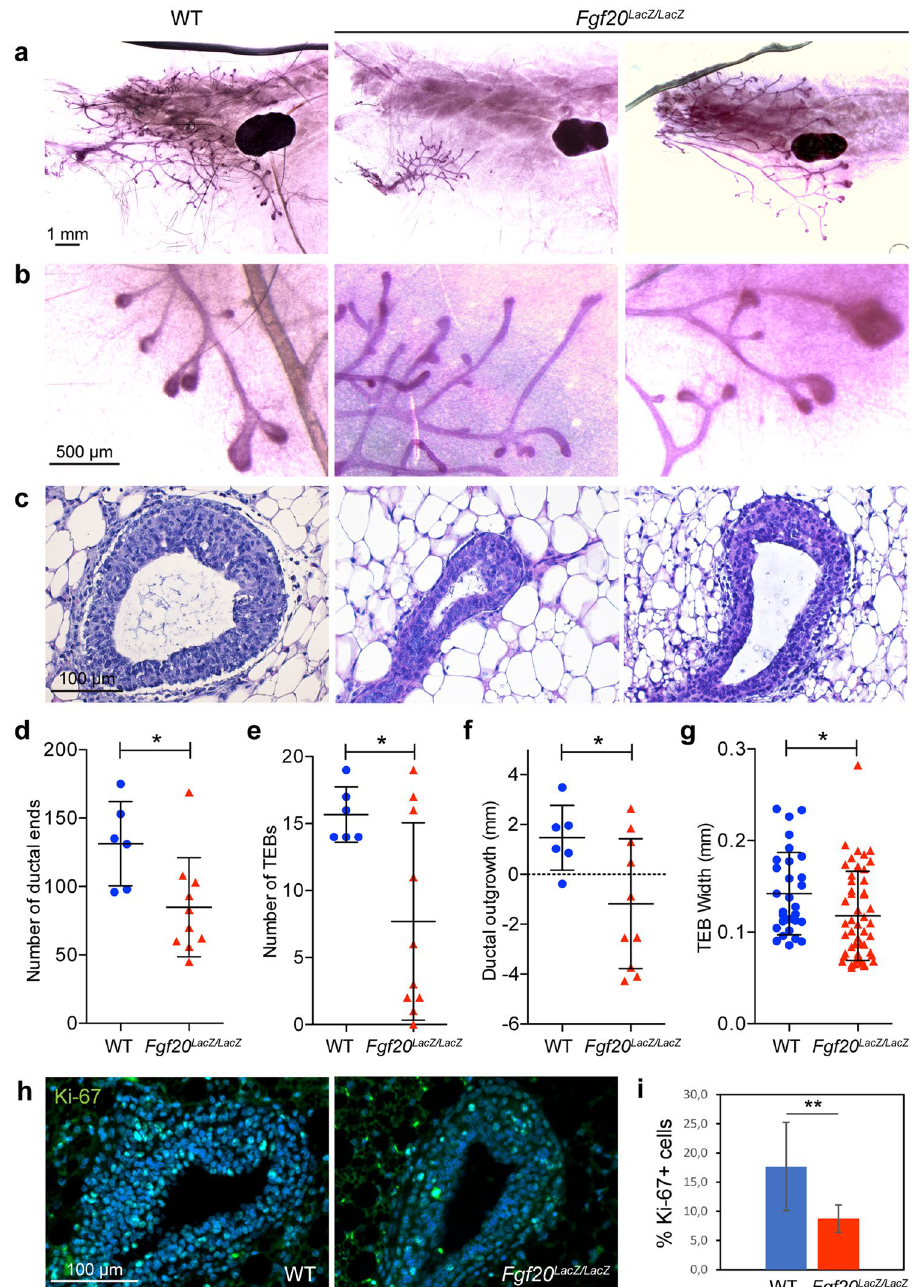
Figure 5. Fgf20 deficiency compromises TEB formation and ductal invasion. ( a–c ) Carmine alum stained ductal trees of the 4 th mammary gland ( a , b ) and histology of TEBs ( c ) of WT and Fgf20 LacZ/LacZ mice at 5 weeks of age. ( d–g ) Quantification of the ductal ends ( d ), TEBs ( e ), ductal outgrowth (measured as the distance of furthest grown ductal end from the center of the lymph node) ( f ), and width of five biggest ductal ends in each gland ( f ) in WT (n = 6) and Fgf20 LacZ/LacZ (n = 10) mice. ( h , i ) Immunohistochemical staining and quantification of Ki-67 -positive cells in TEBs of WT (n = 4) and Fgf20 LacZ/LacZ (n = 3) mice. Total number of TEBs analyzed was n = 15 (WT), n = 9 ( Fgf20 LacZ/LacZ ). Bars show mean ± SD. * p < 0.05; ** p <